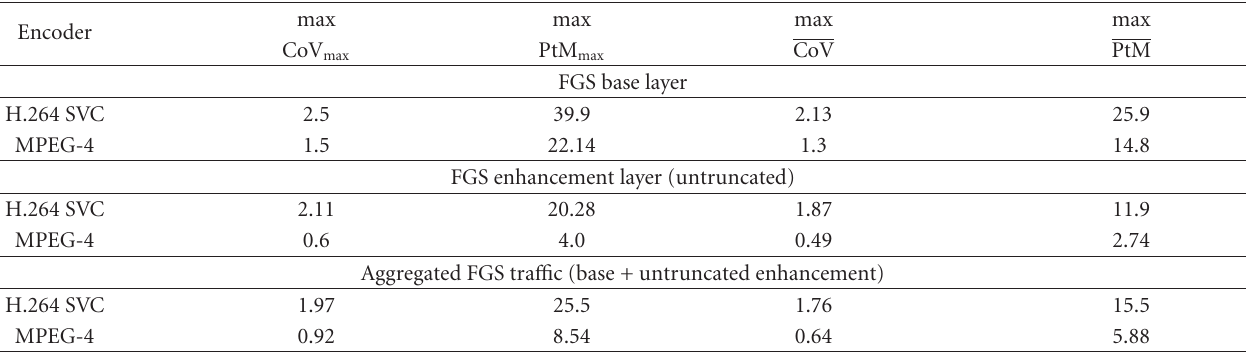
Table 7: Maximum-of-maximum, and maximum-of-mean CoV and PtM values of SVC FGS and MPEG-4 FGS base and enhancement layers, and aggregated tra ffi c.